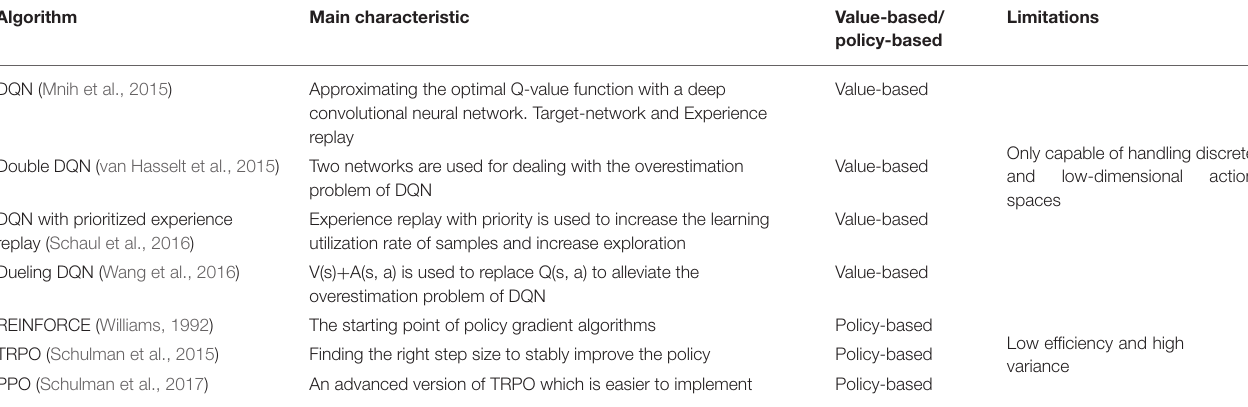
TABLE 3 | Comparison between typical value-based algorithms and policy-based algorithms.